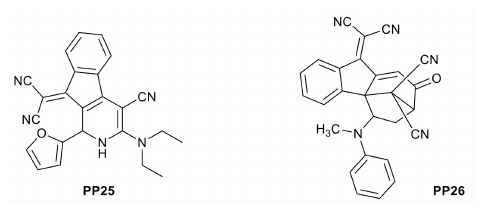
Figure 2. Chemical structures of DASA 1 – DASA 13 , PP25 and PP26